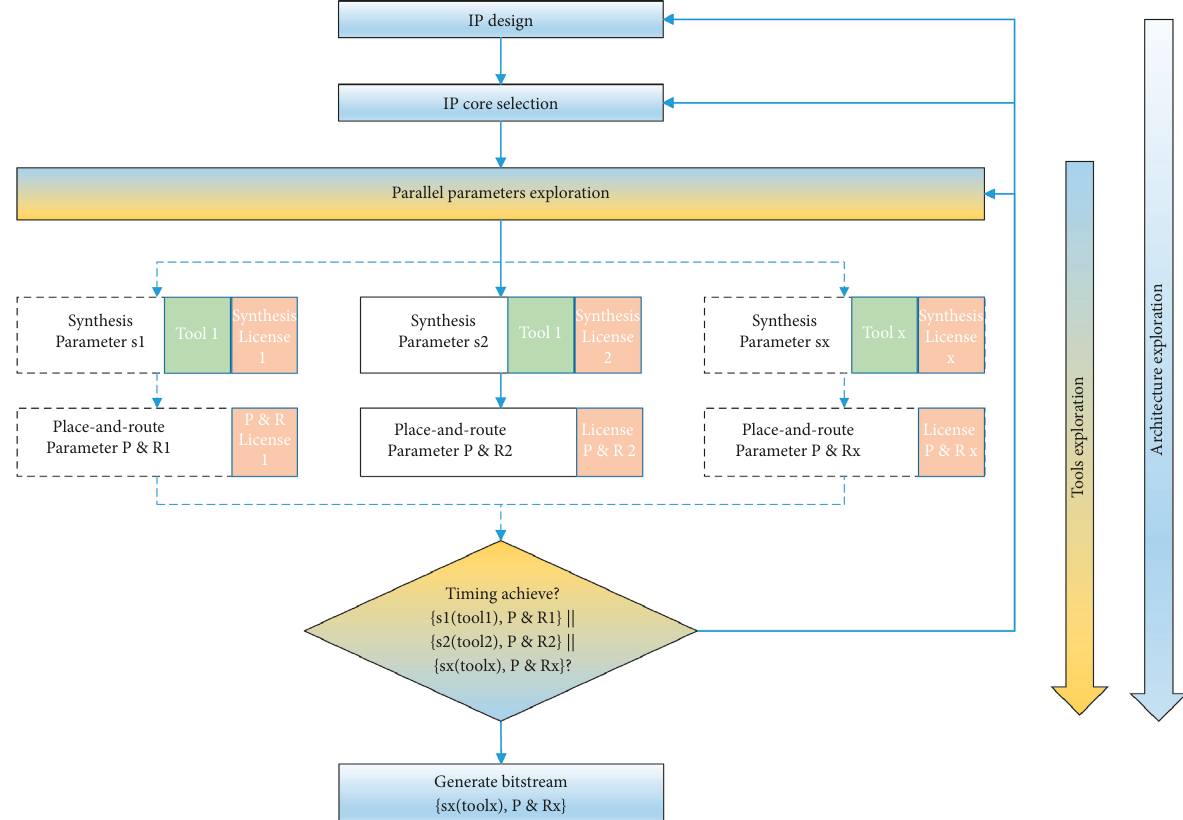
Figure 2: Example of FPGA design flow with parallel parameters